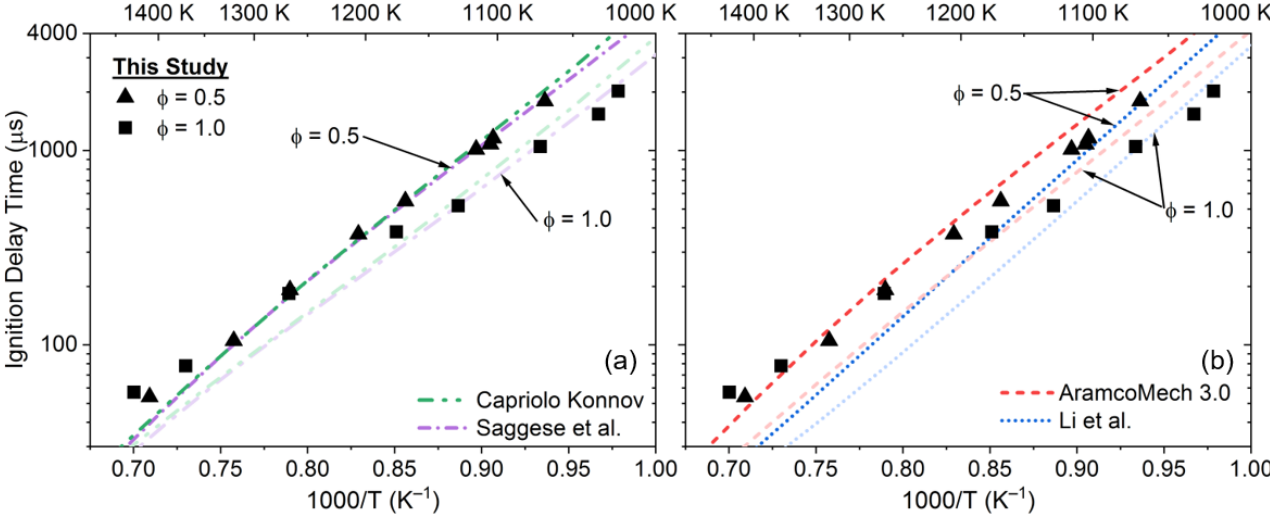
Figure 7. Ignition delay time results for the fuel-lean and stoichiometric cases at 10 atm. Model predictions are also shown for ( a ) Capriolo and Konnov and Saggese et al. and ( b ) AramcoMech 3.0 and Li et al.